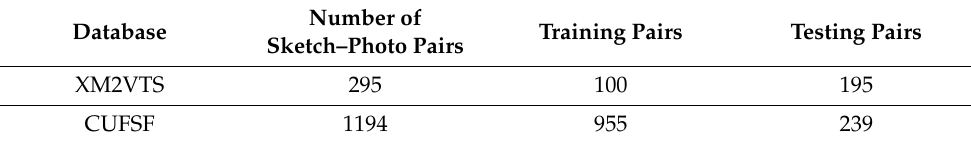
Table 8. The studied database